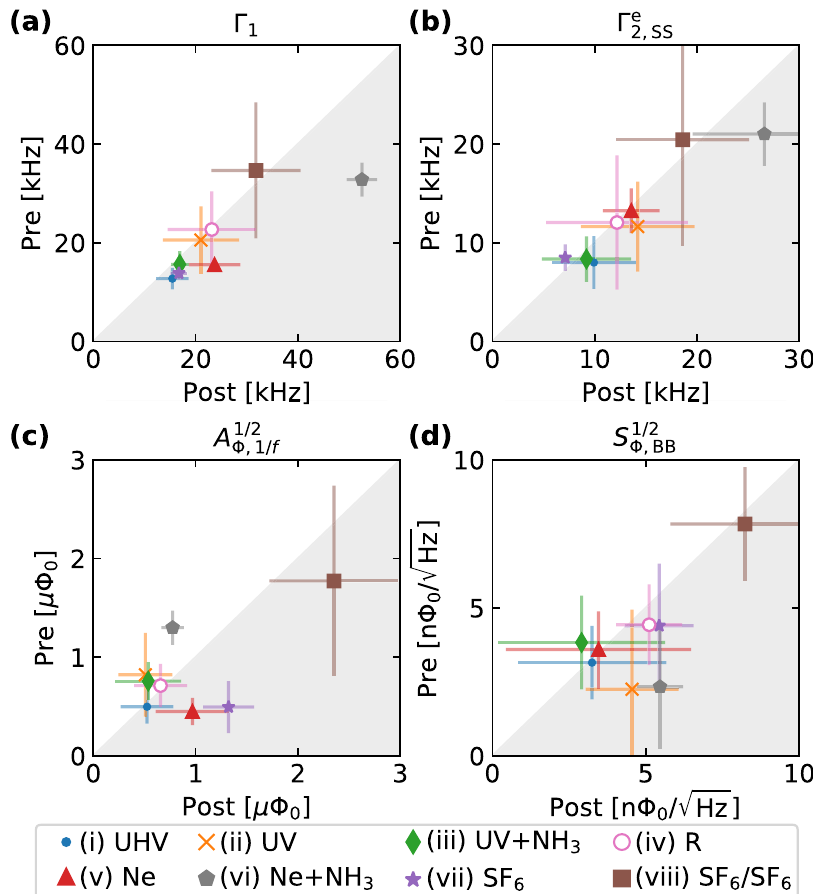
Fig. 3 Impact of surface treatments on qubit coherence. Mean qubit parameters pre- ( y -axis) and post-treatment ( x -axis) are compared, where the gray shaded area indicates a degradation and conversely the white area of the graph an improvement in the parameters. a Weighted mean of Γ 1 over the entire fl ux interval, with the standard deviation of the spread used as weights. Error bars indicate the measured at the sweet spot of the qubits. Error bars indicate the standard deviation of weighted mean of the spread. b Mean value of Γ e 2 ; SS values measured across multiple qubits. Weighted mean values of A 1 = 2 Φ ; ( c ) and S 1 = 2 Φ ; ( d ) extracted from quadratic fi ts to Γ e and weighted by 2 ; Φ BB 1 = f the fi t error. Error bars indicate the weighted standard deviation of the mean